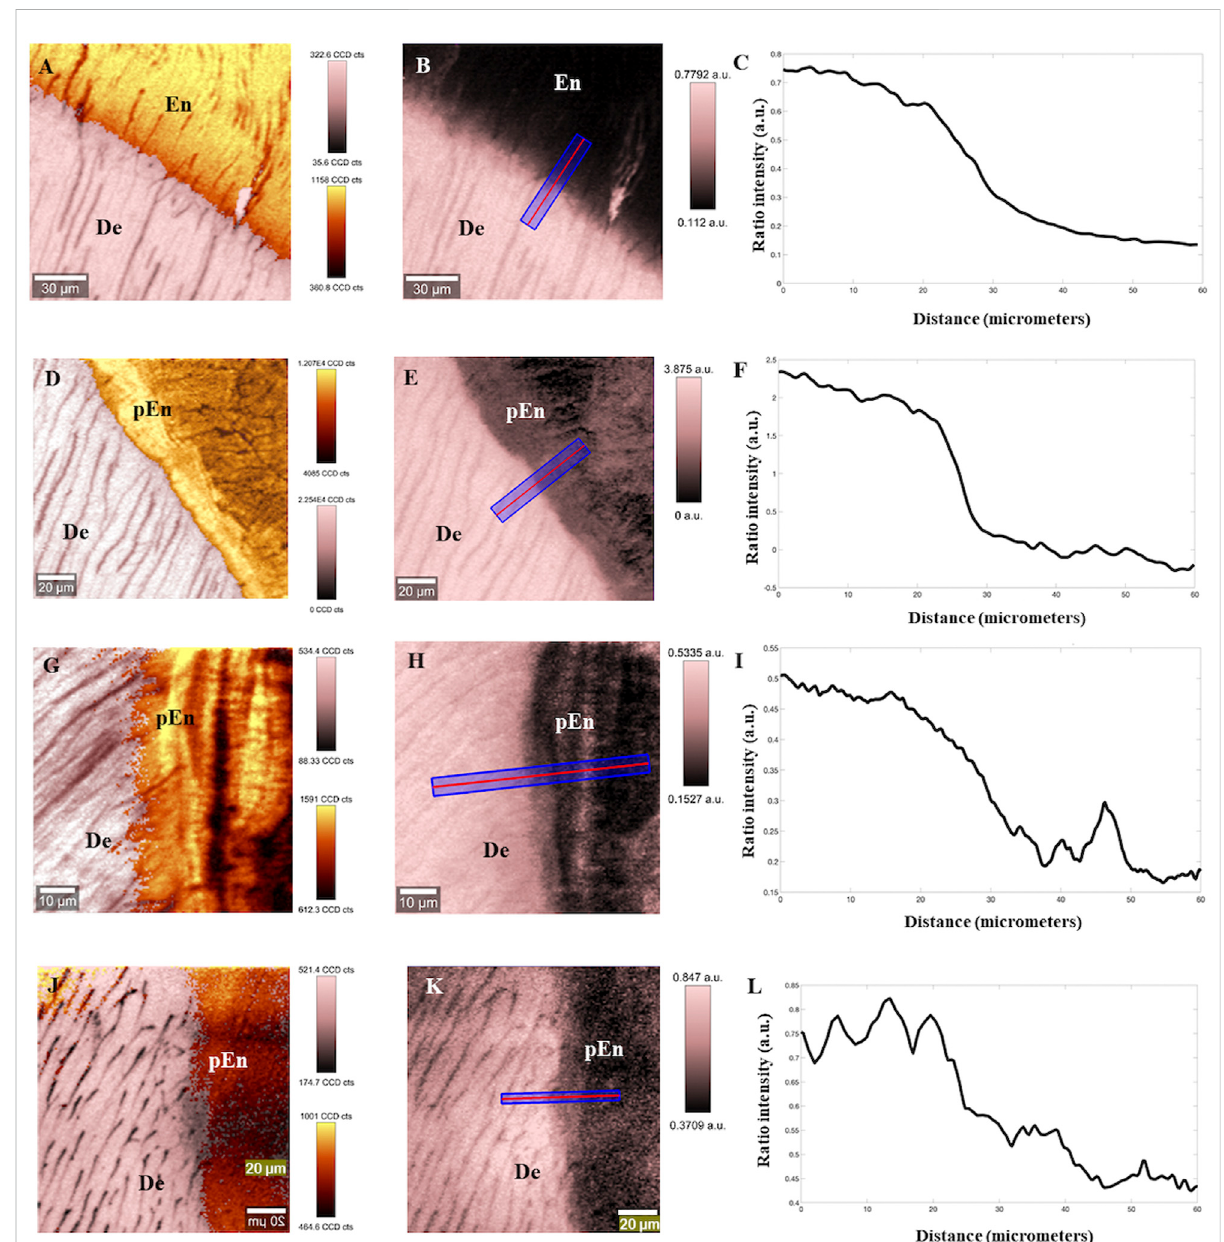
FIGURE 4 Reconstructed images of control (deciduous) tooth and ERS at the DEJ area. (A) Chemical combined image of phosphate/960 cm − 1 peak (yellow hue) intensity and CH/2,800 cm − 1 peak (pink hue) intensity of DEJ in sound deciduous teeth with two look up tables; (B) image ratio of CH/ 2,800 cm − 1 intensity peak divided by phosphate/960 cm − 1 peak intensity with look up table on sound deciduous sample. (C) plotted pro fi le of ratio DEJ, following blue line in (B,D) Chemical combined image of phosphate/960 cm − 1 peak (yellow hue) intensity and CH/2,800 cm − 1 peak (pink hue) intensity of DEJ in ERS4 adult teeth with two look up tables; (E) image ratio of CH/2,800 cm − 1 intensity peak divided by phosphate/960 cm − 1 peak intensity with look up table of ERS4 sample. (F) plotted pro fi le of ratio DEJ, following blue line in (E) . (G) Chemical combined image of phosphate/960 cm − 1 peak (yellow hue) intensity and CH/2,800 cm − 1 peak (pink hue) intensity of DEJ in ERS2 adult teeth with two look up tables; (H) image ratio of CH/2,800 cm − 1 intensity peak divided by phosphate/960 cm − 1 peak intensity with look up table of ERS2 sample. (I) plotted pro fi le of ratio DEJ, following blue line in (E) . (J) Chemical combined image of phosphate/960 cm − 1 peak (yellow hue) intensity and CH/2,800 cm − 1 peak (pink hue)intensityofDEJinERSERS3adultteethwithtwolookuptables; (K) imageratioofCH/2,800 cm − 1 intensitypeakdividedbyphosphate/960 cm − 1 peak intensity with look up table of ERS3 sample; (L) plotted pro fi le of ratio DEJ, following blue line in (E) . De, dentin; En, enamel; pEn, pseudo